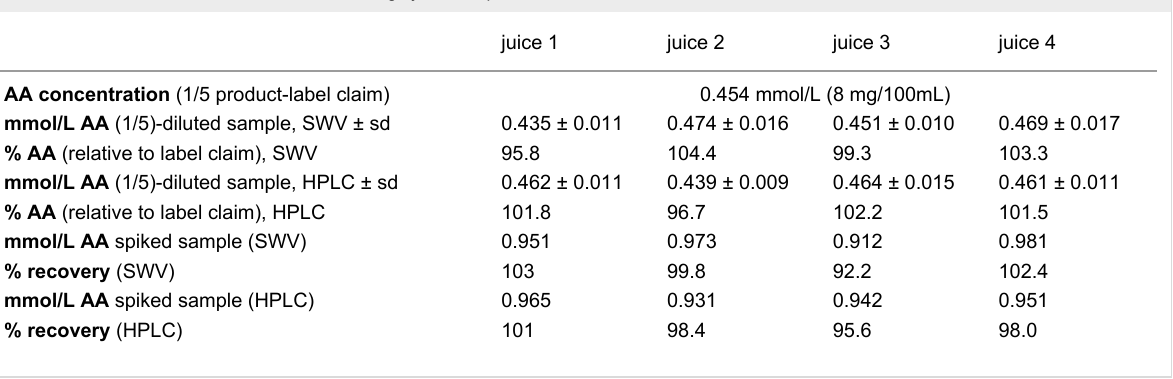
Table 2: Ascorbic acid content of commercial orange-juice samples.